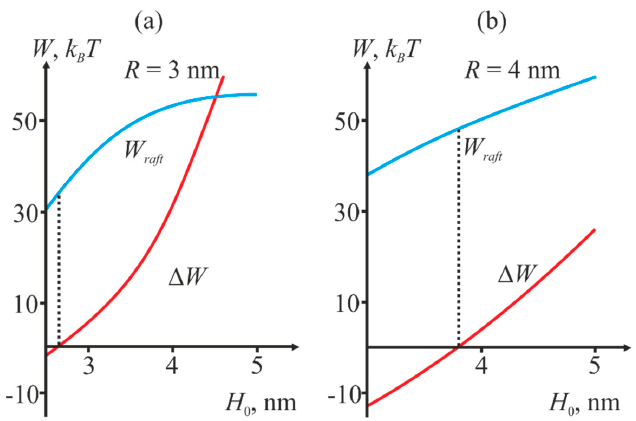
Figure 5. Dependence of W raft (blue curve) and Δ W (red curve) on the initial distance H 0 between the membranes at different values of the fusion rosette radius R . ( a ): R = 3 nm; ( b ) R = 4 nm. The height of the barrier corresponding to intersection of the red line with the abscissa corresponds to the minimal energy needed to achieve the stalk state in the presence of a raft (shown by vertical dashed lines).